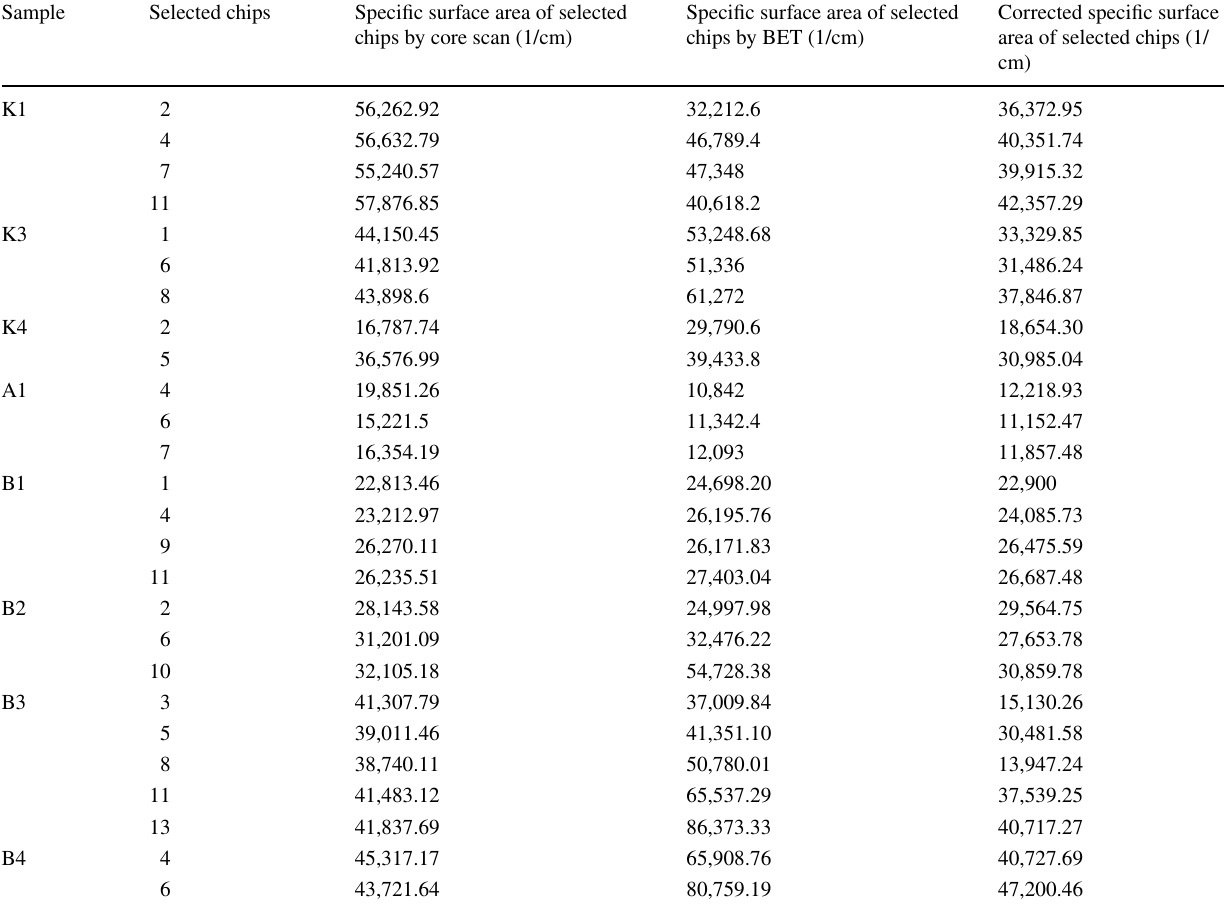
Table 8 Specific surface area of selected chips by core scan and BET and corrected specific surface area of selected chips Sample Selected chips Specific surface area of selected Specific surface area of selected Corrected specific surface chips by core scan (1/cm) chips by BET (1/cm) area of selected chips (1/